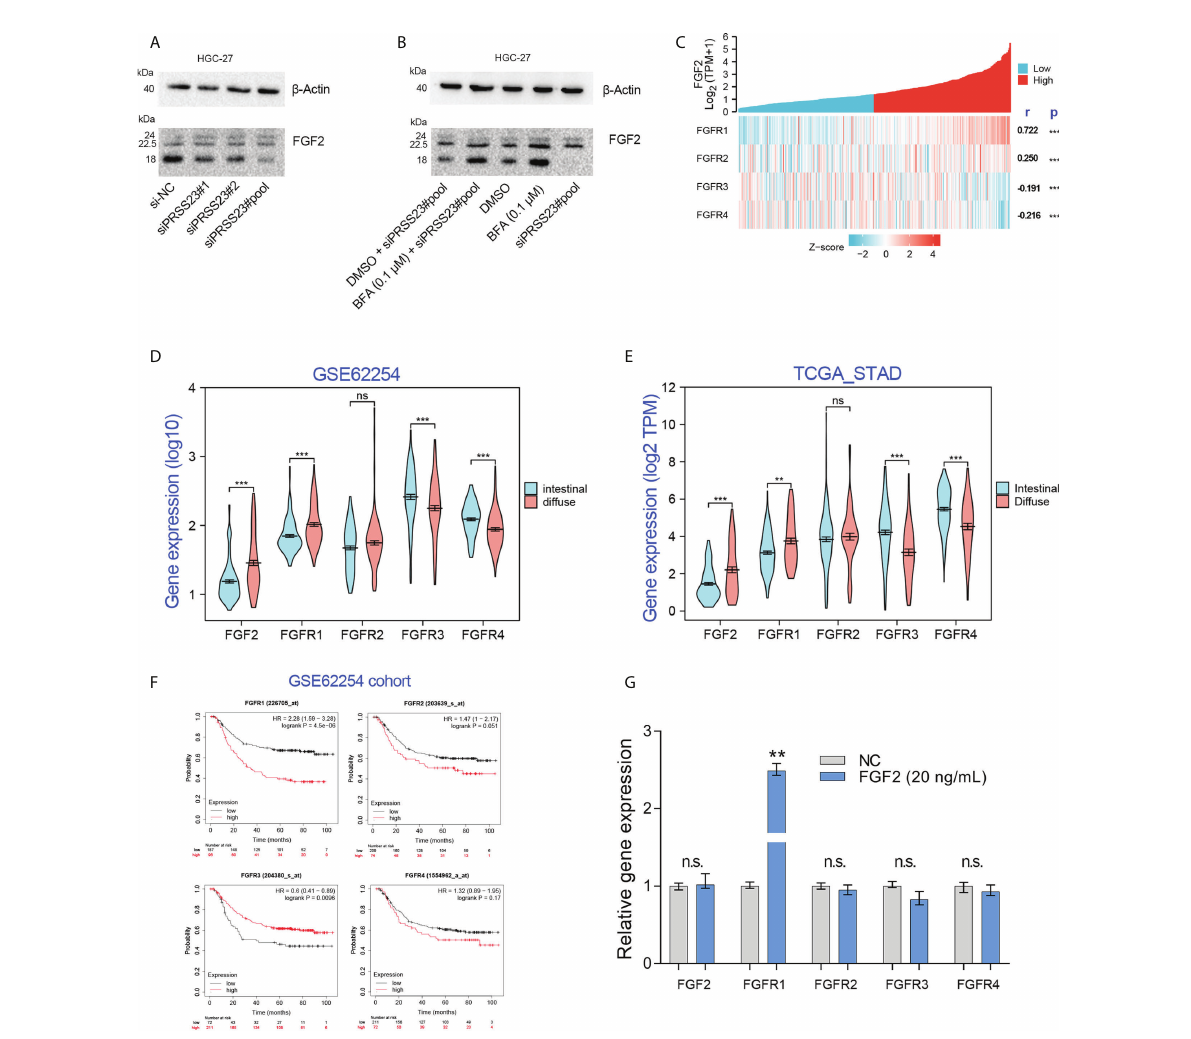
FIGURE 8 Exogenous recombinant FGF2 signi fi cantly upregulated FGFR1 expression in GC. (A) Western blotting assay con fi rmed that PRSS23 knockdown mainly affected low weight molecular FGF2 (18 kDa) expression in GC. (B) The experiments combining blockade of FGF2 secretion by Brefeldin A (BFA) with PRSS23 knockdown were performed. (C) The gene expression correlation between FGF2 and its receptors in TCGA_STAD cohort. (D, E) The expression levels of FGF2/FGFR1/2/3/4 were analyzed in two independent GC cohorts. (F) Survival analysis of FGF2/FGFR1/2/3/4 in GSE62254 cohort. (G) The expression levels of FGF2/FGFR1/2/3/4 were determined by qRT-PCR after treatment with recombinant FGF2 in HGC-27 cells. **p < 0.01, ***p < 0.001, ns means no signi fi